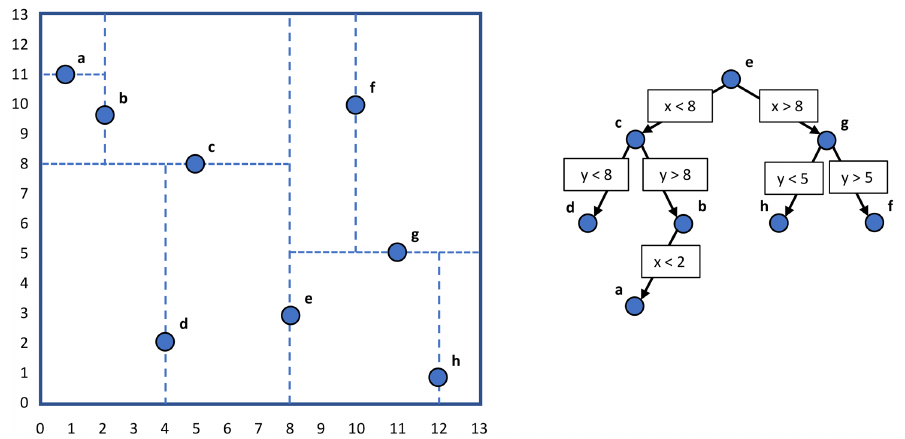
2) built from nodes a through h. Dividing planes are constructed by cycling through Figure 3. An example two-dimensional k -d tree ( k = each coordinate and determining the median node (left). This gives rise to a tree structure (right) that, in conjunction with an input node, can then be searched recursively for a corresponding rectangular domain in physical space. The last leaf node is labeled as the best candidate for nearest neighbor and the tree is “unwound” to test other potential candidates. The number of nodes that need to be examined is limited to domains that overlap a hypersphere with origin at the input node and with distance to the current candidate.